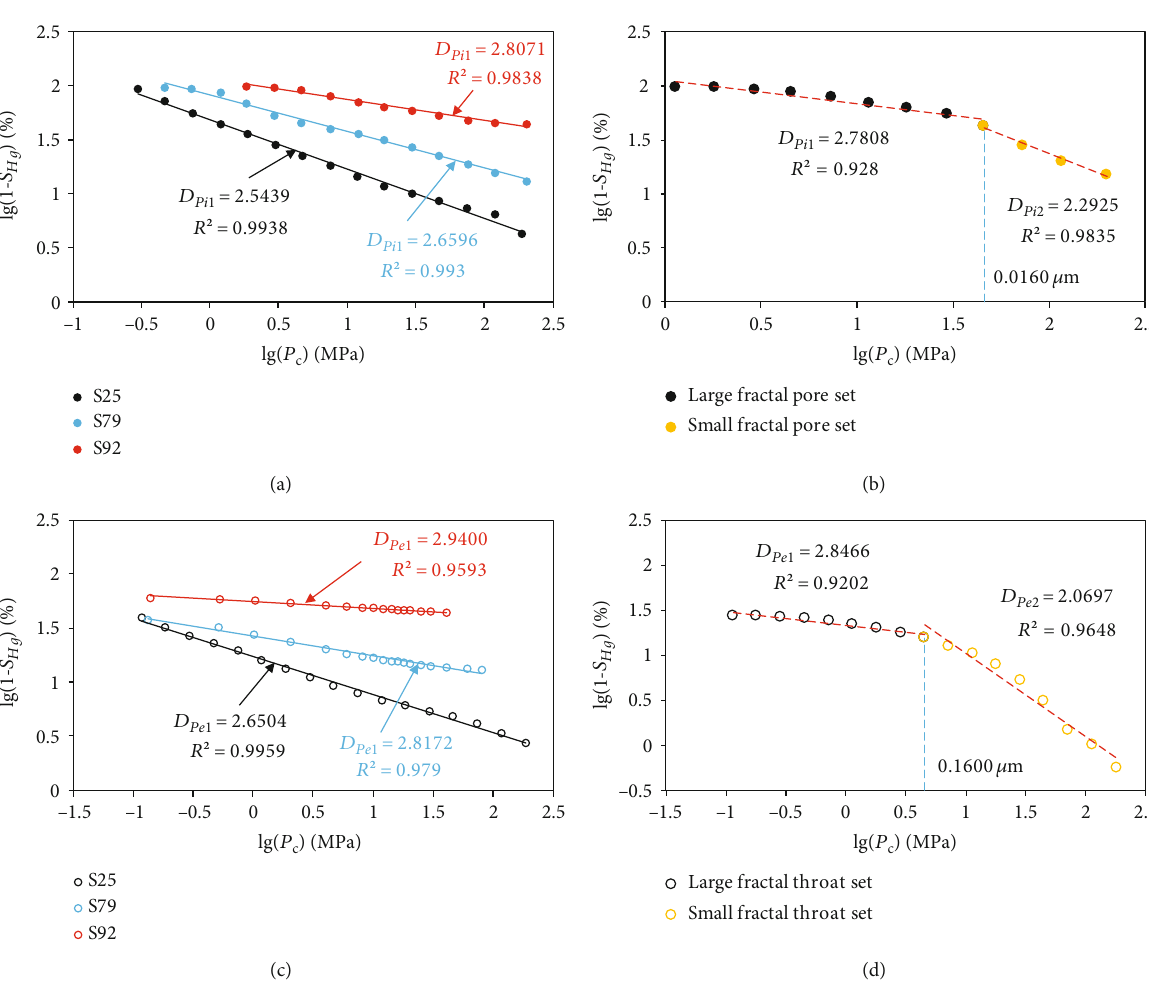
: Pi 1 : small fractal pore set; D : fractal dimension Pi 2 Pe 1 : small fractal throat Pe 2